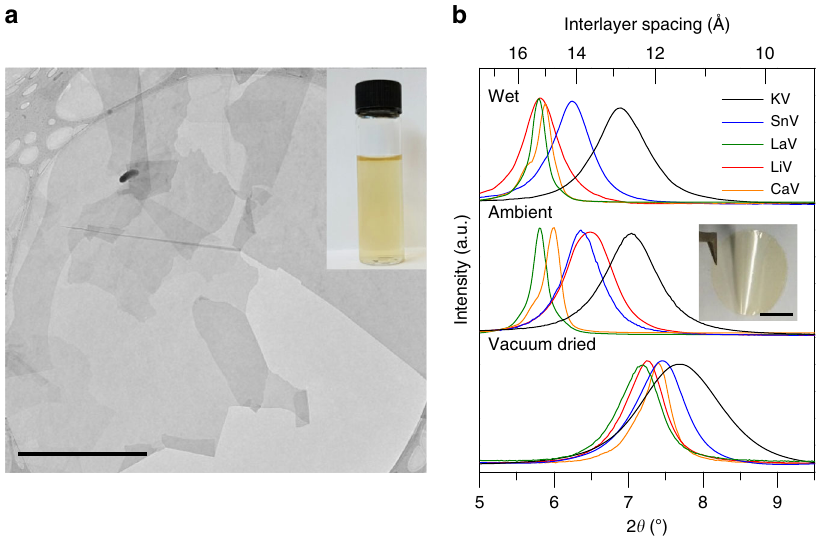
Fig. 1 Cation exchanged vermiculite laminates. a Transmission electron microscope (TEM) image of exfoliated lithium vermiculite fl akes. Scale bar, 10 µ m. Inset: Photograph of an aqueous dispersion of exfoliated vermiculite. b X-ray diffraction (XRD) pattern of free-standing K-, Sn-, La-, Li-, and Ca-vermiculite laminates in vacuum dried (12 h), ambient ( ∽ 40% relative humidity) and wet states. Source data are provided as a Source Data fi le. Inset: Photo of a 5- µ m-thick free-standing Li-vermiculite laminate. Scale bar, 1 cm. It is noteworthy that the distribution of interlayer spacing of ion-exchanged vermiculite laminates signi fi cantly changes after its exposure to water or humid air. This suggests that the hydration of the membrane in fl uences the quality of the laminar structure of the